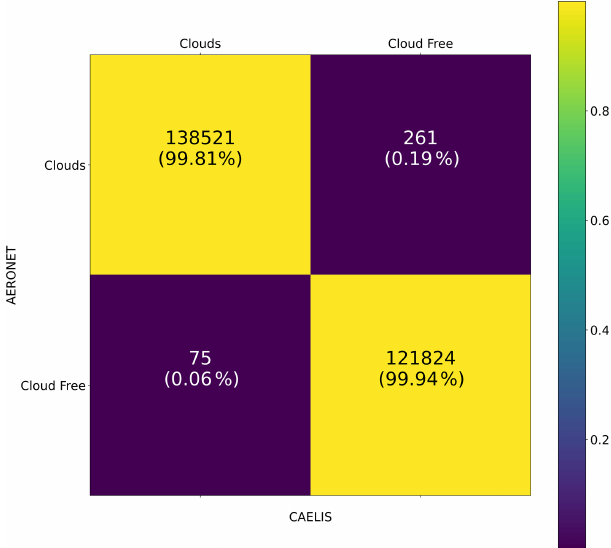
Figure 9. Confusion matrix for comparison of the cloud screening performed by AERONET and CÆLIS. Absolute number of cases and relative values (in percent) are